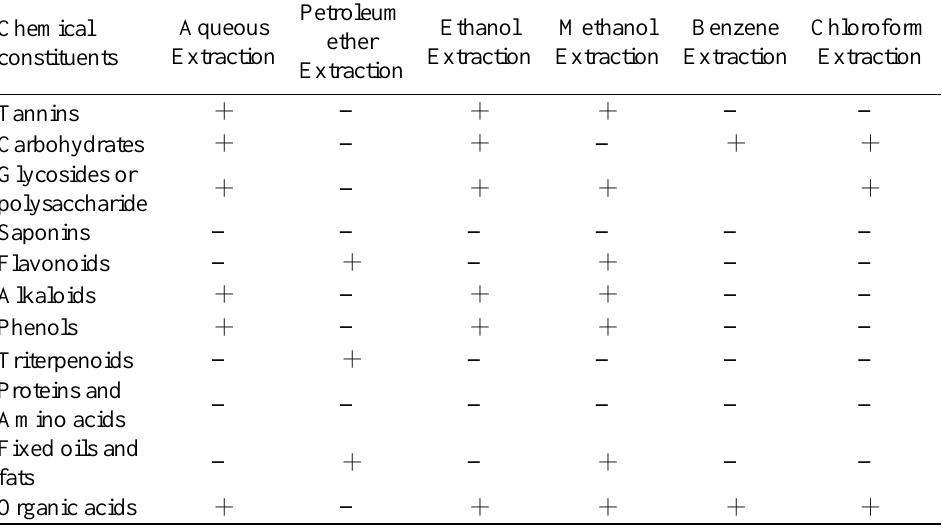
Table 3. Phytochemical tests of the successive extracts of P. sinjiangensis K. Y.